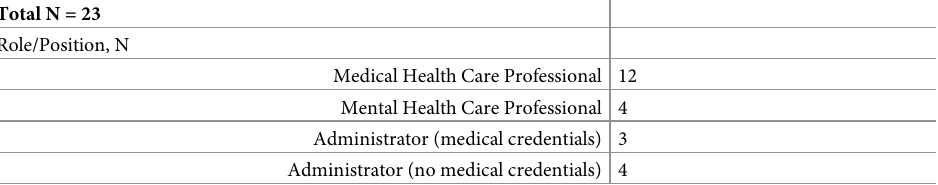
Table 2. Roles of health care professionals who participated in in-depth